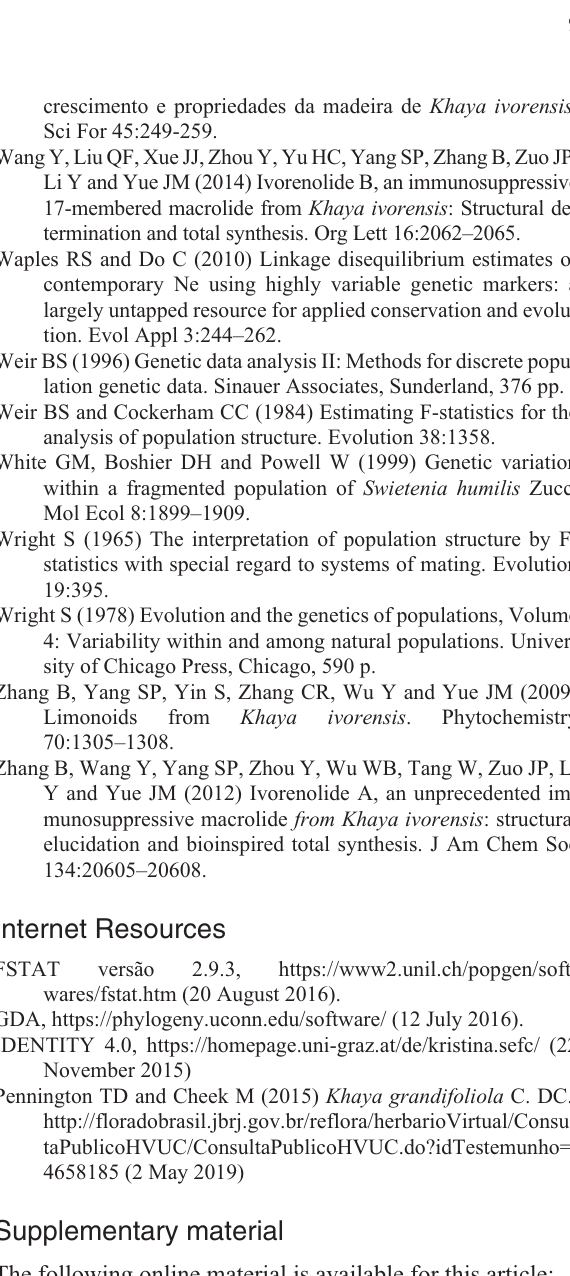
Figure S1 – Localization of the two farms (Norton’s and Okajima’s), in Pará state (Brazil), where the 53 trees were selected. Figure S2 – Results from Structure depicting the likelihood for the different number of clusters